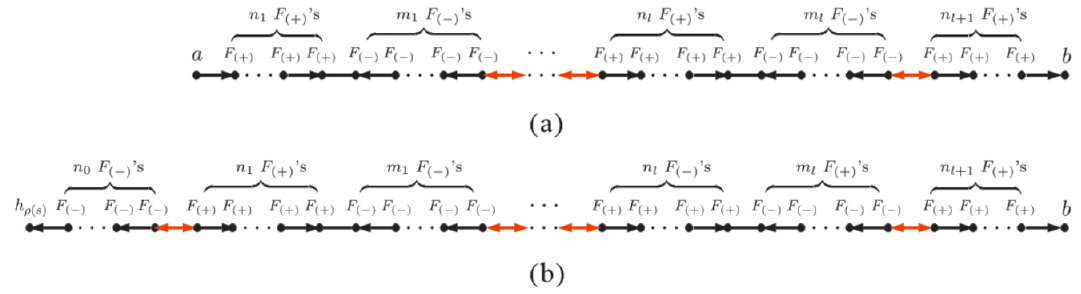
g and h de(cid:12)ned by the (cid:26) ( s ) (cid:26) ( s ) ) (cid:1) ( F (cid:1) : : : ) (in (a) and (b)) or (cid:15) a (cid:1) ( F (cid:1) : : : ) (+) ( (cid:0) ) ( (cid:0) ) ) (cid:1) ( F (cid:1) : : : ) (in (a) and ( (cid:0) ) (+) (cid:1) k b (in (b)) provides a type-3 line. (cid:26) ( s )